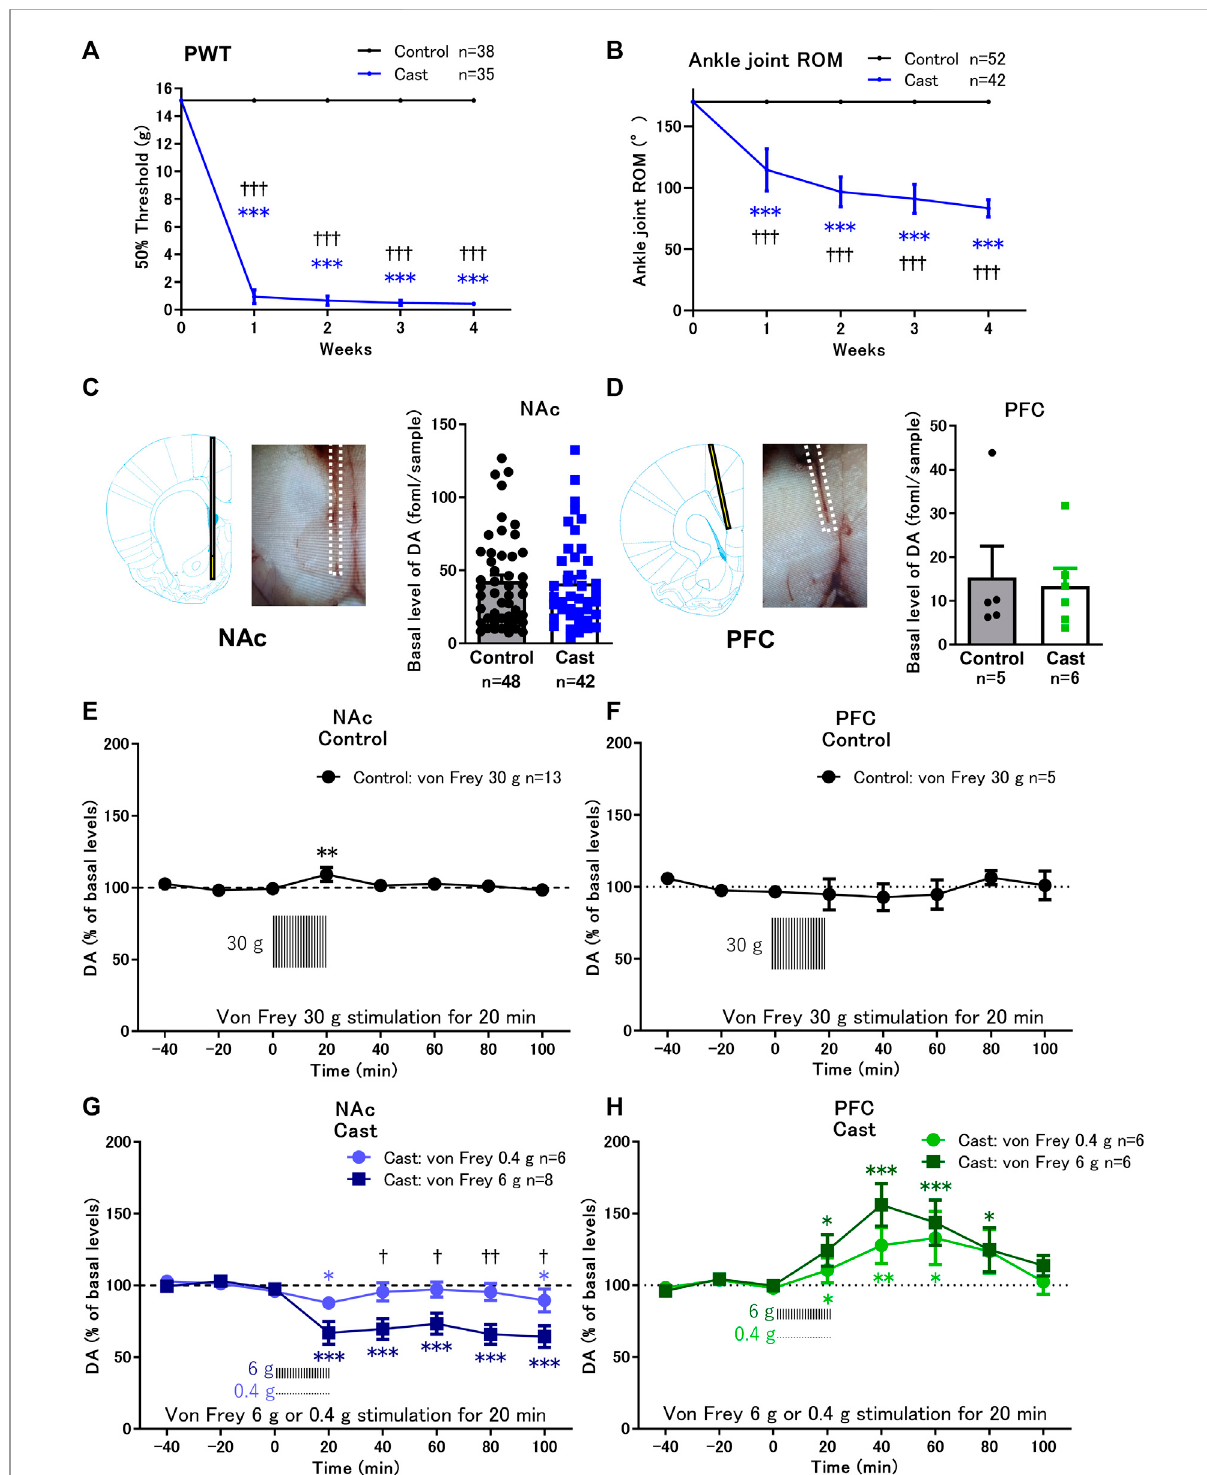
FIGURE 1 Effects of cast immobilization of the left hind limb on the paw withdrawal threshold (PWT), range of motion (ROM), and von Frey fi lament stimulation-induced changes of dopamine (DA) in the nucleus accumbens shell (NAcSh) and prefrontal cortex (PFC). (A,B) Cast immobilization signi fi cantly decreased thePWT (A) and ROM ofthe ankle joint (B) inthe cast group. *** p < 0.001 versusPWTand ROM at0 week; ††† p < 0.001 versus the control group; two-way ANOVA and Sidak ’ s multiple comparisons test. (C,D) Representative traces of microdialysis probe placed in the